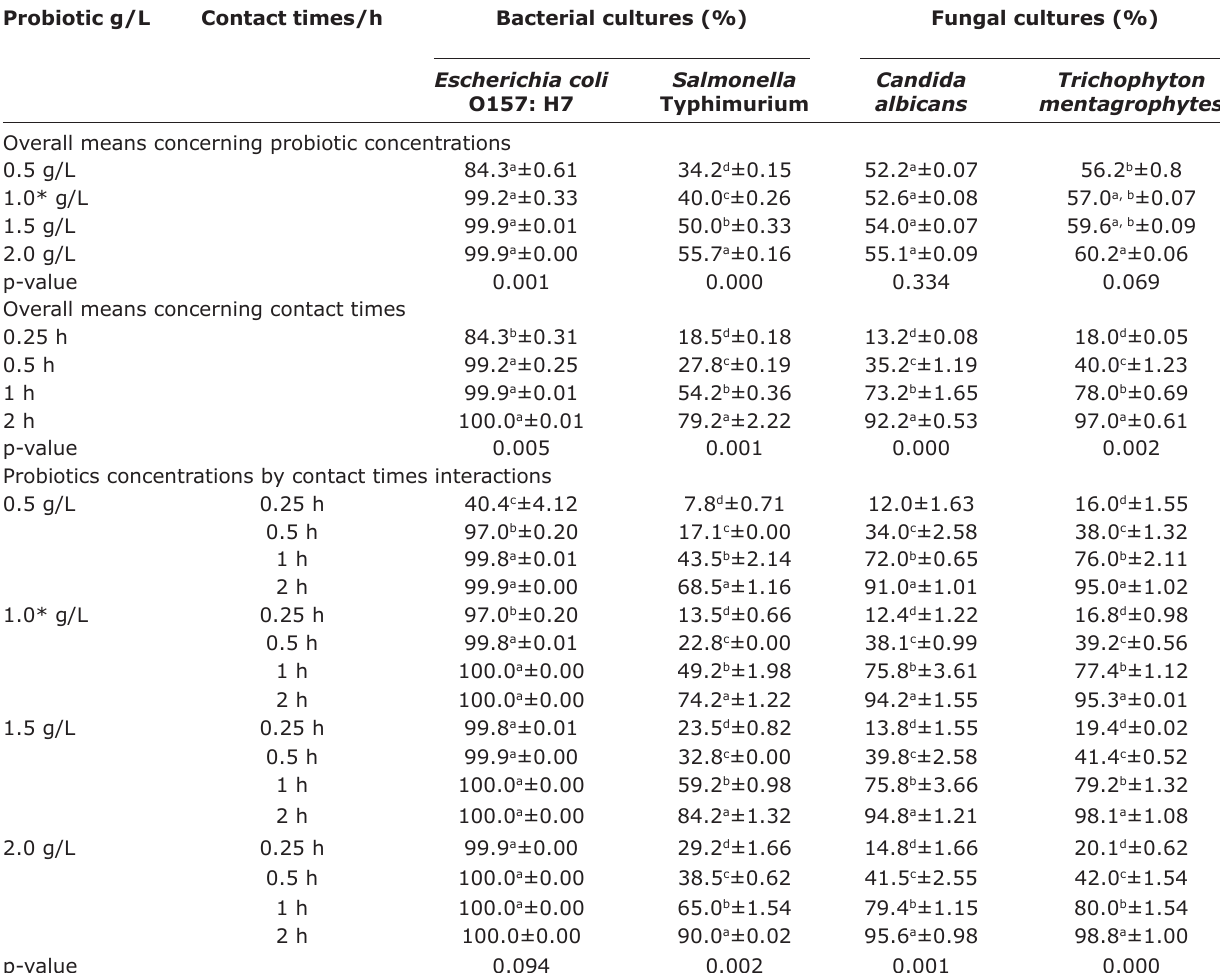
Table-1: In vitro antimicrobial action (killing rate mean±SE) of different Bacillus subtilis probiotic’ concentrations at different exposure times. Probiotic g/L Contact